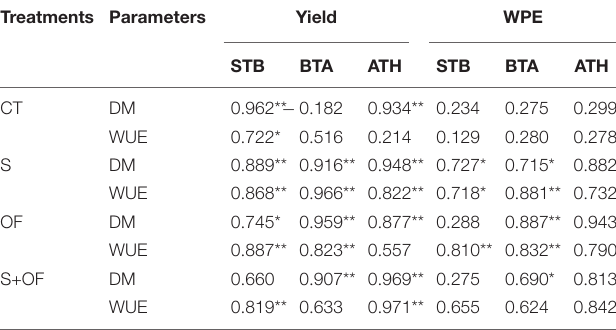
TABLE 6 | The proportion of different diameters of aggregates under subsoiling, organic fertilizer and subsoiling combined with organic fertilizer. Treatments The proportion of different diameters of aggregates (%)